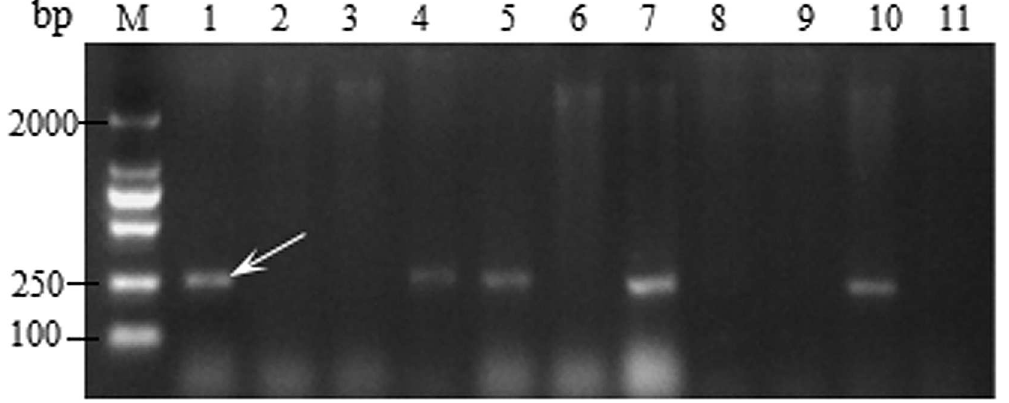
Fig 6. Amplification result for parts of wheat varieties with Xcmwg682. Lane 1–11, Monogenic Sr38 , Little Club, Water control, De 05–81, Feng 1124, Yumai 1, Liangmai4, De 0716, Dianmai 34, Feng 1128, and De 07–19. ‘M’ indicates2000 bp DNA ladder and white arrow indicatesthe position of the specific